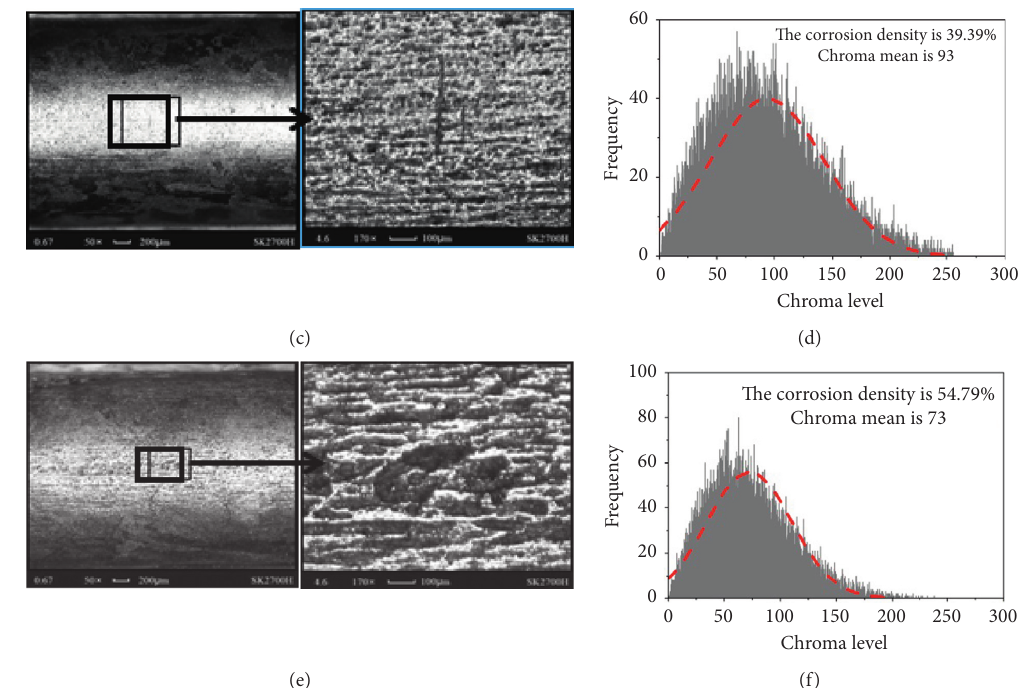
Figure 8: Local corrosion and corrosion histogram of steel strand under different stress loadings: (a) local corrosion figure under no stress (720 h); (b) corrosion histogram of no stress; (c) local corrosion figure under static stress (720 h); (d) corrosion histogram of static stress; (e) local corrosion figure under alternating stress (720h); (f) corrosion histogram of alternating stress.